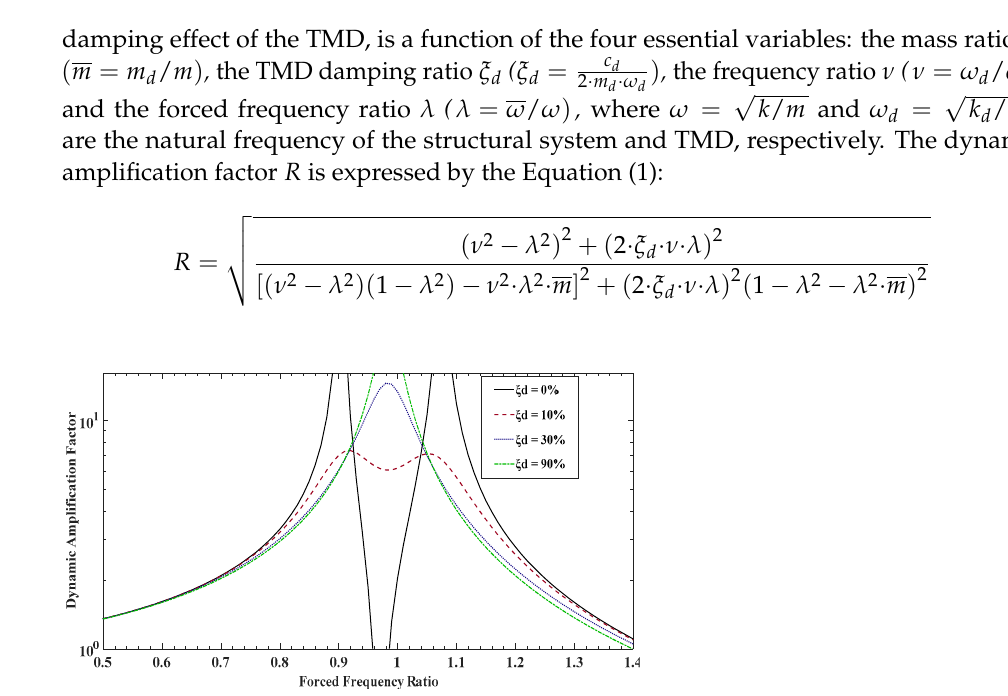
Figure 5. PTMD schematic representation.